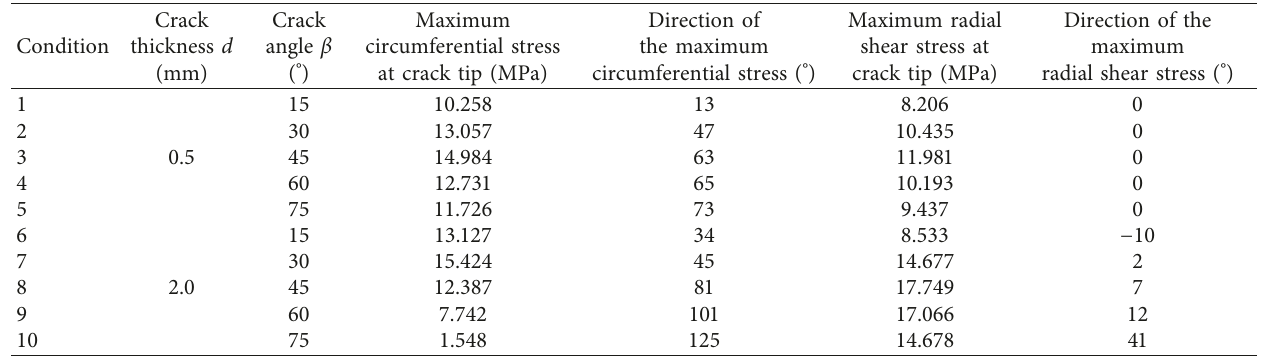
Table 3: Numerical results of stress near the crack tip.